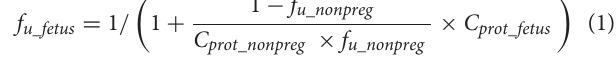
Maternal fraction unbound